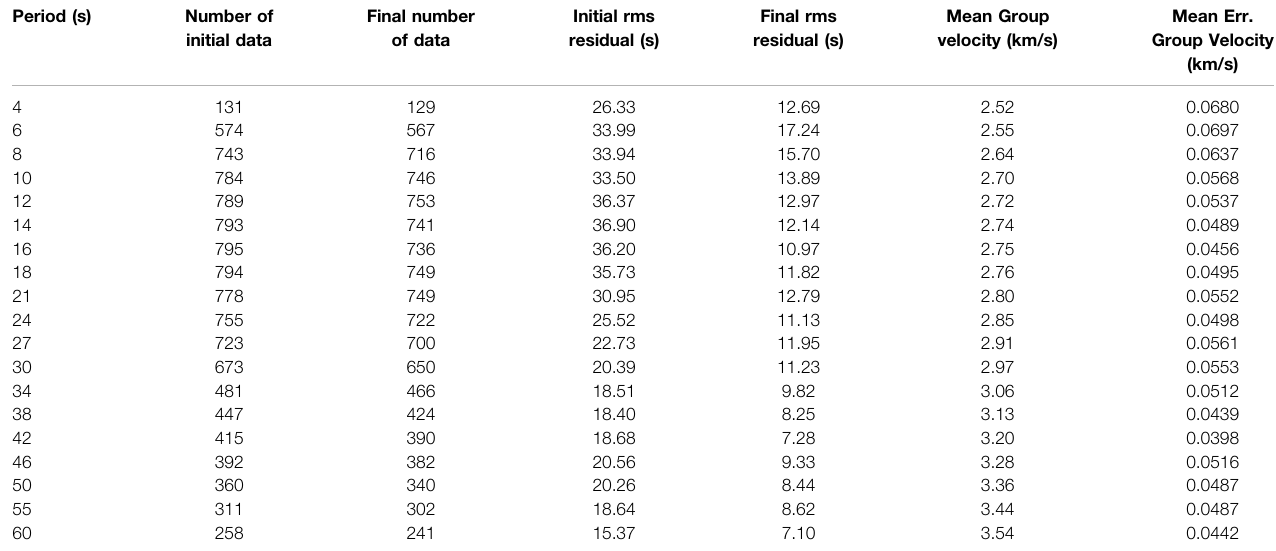
TABLE 2 | Group-velocity tomographic inversion details. Number of data (paths), fi nal number of data after excluding outliers, initial rms residual (before tomography), fi nal rms residual (after tomography), and averaged group velocity after tomographic inversion for different periods with mean error. Period